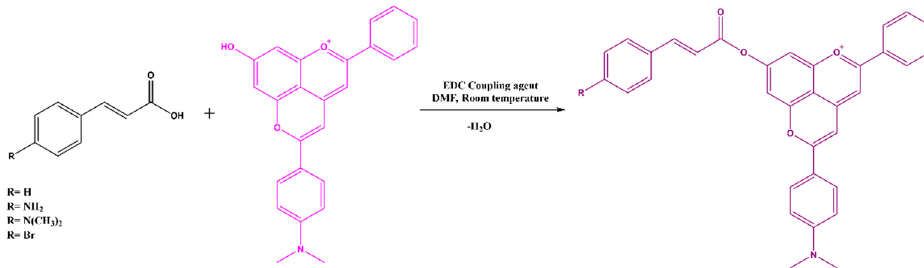
Figure 15. Functionalization of a 7-hydroxy amino-based pyranoflavylium compound using one-pot 1-(3-dimethylaminopropyl)-3-ethylcarbodiimide hydrochloride (EDC) coupling chemistry.